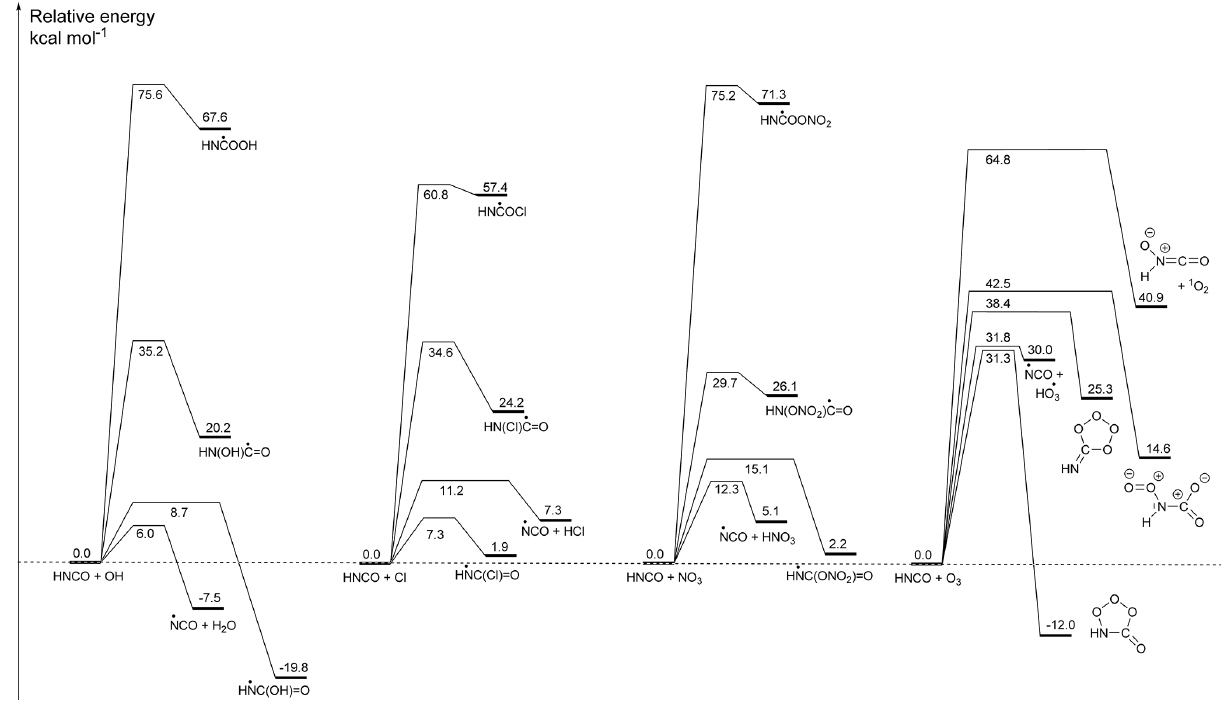
Figure 1. Potential energy surfaces for the initiation reactions of HNCO with OH radicals, Cl atoms, NO 3 radicals, and ozone, showing CCSD(T)/CBS(DTQ) energies (kcalmol − 1 ) based on M06-2X/aug-cc-pVTZ geometries. The pre-reactive complexes are omitted as they do not influence the kinetics; similarly, the subsequent reactions of the products are not shown. The Supplement has additional energetic and rovibrational data, more complete potential energy surfaces for some of the reactions, and three-dimensional representations of the molecular structures with bond lengths and angles.